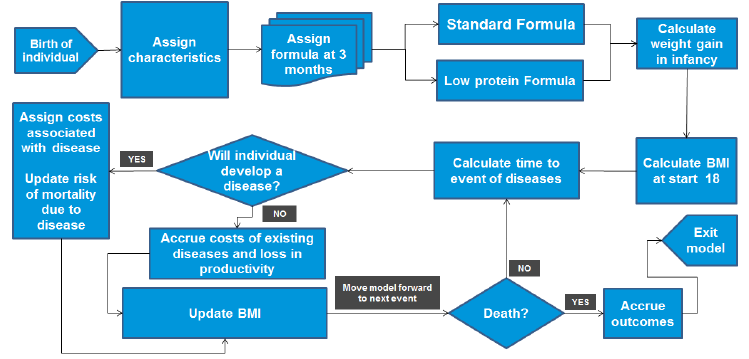
Figure 1. Flow diagram of the model; BMI, body mass index.